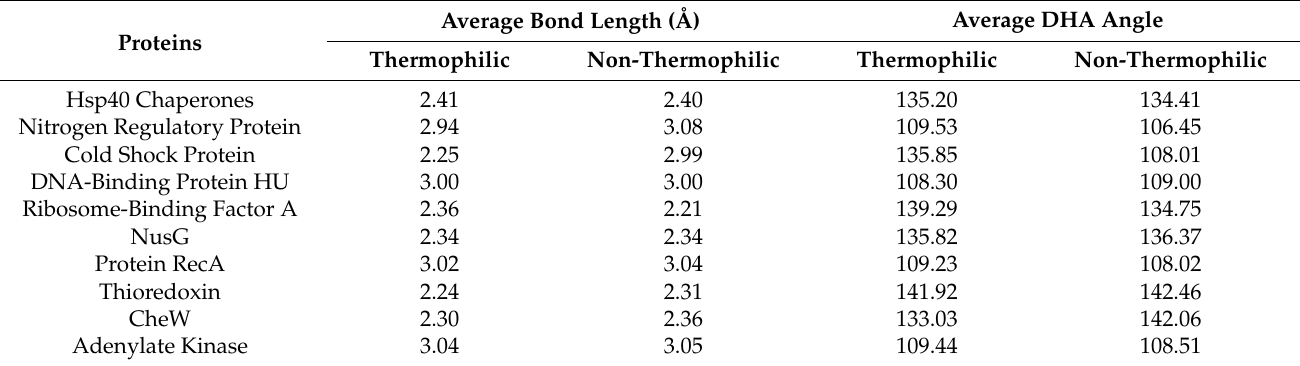
Table 3. Average bend length and DHA angle in thermophilic and non-thermophilic